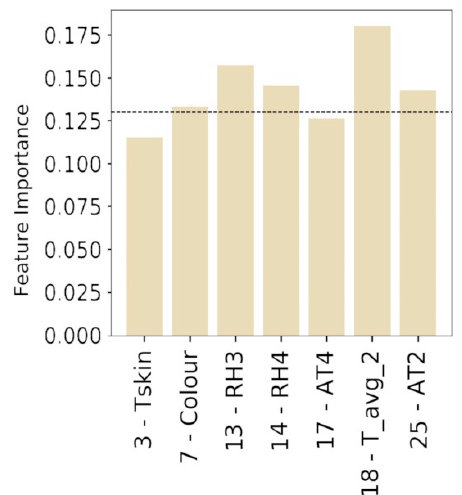
Figure 11. Relative feature importance of Extra Trees classifier using a restricted number of data in order to define PTCP_VR.